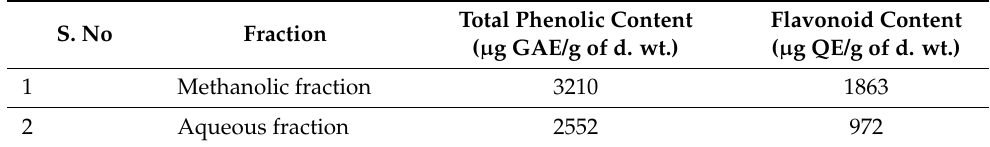
Table 1. Phytochemical analysis of different solvent extracts of B. hochstetteri . Ethyl Methanol Hexane Aqueous Extract Acetate Tests Extract Extract Extract Alkaloids − − + − Flavonoids − − + + Glycosides − − + − Phenols − − + + Saponins − − − + Tannins − − − − Terpenoids − − + + Steroids − + + −